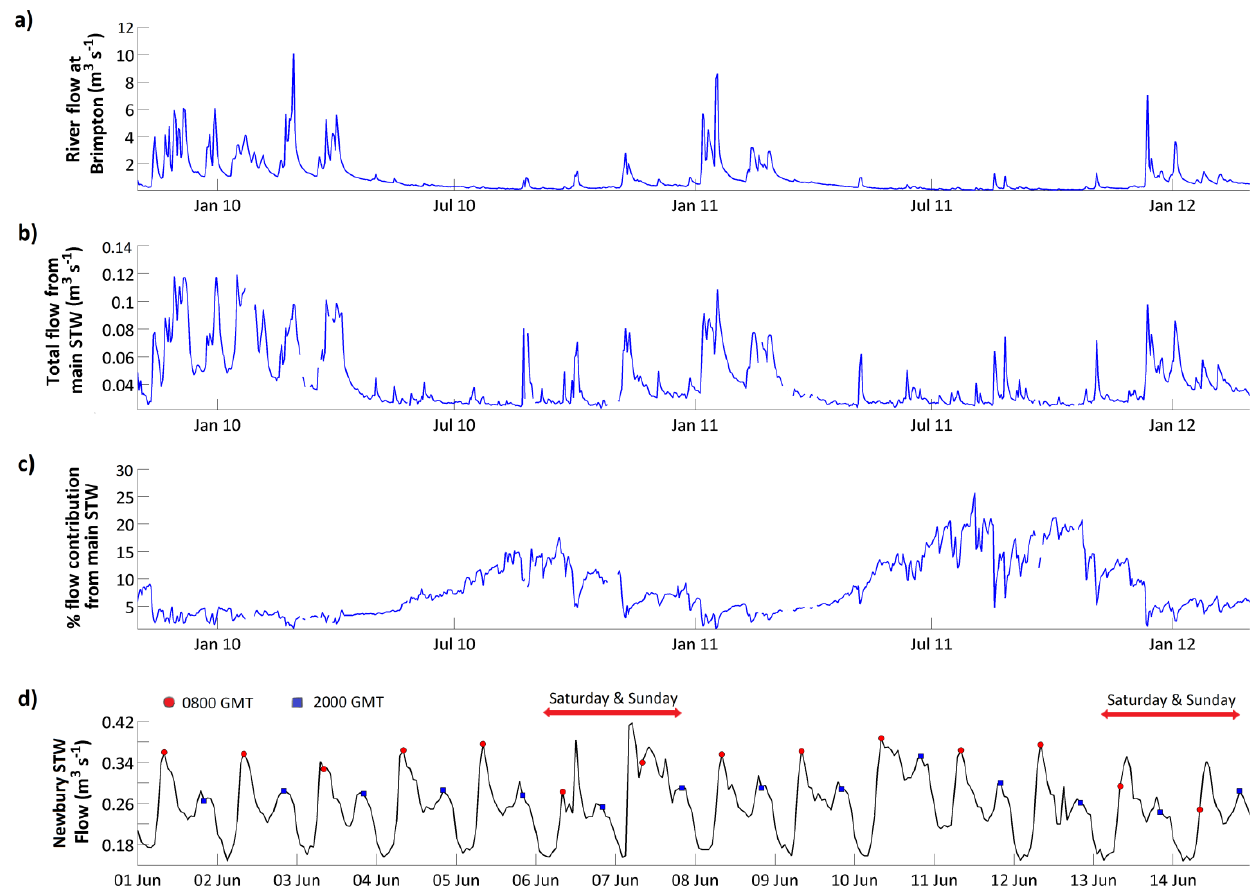
Figure 7. ( a ) Measured flow at Brimpton; ( b ) measured discharges from the three major sewage treatment works (Table 3); ( c ) Percentage contribution of STW discharges to observed river flow at Brimpton; ( d ) discharge from Newbury STW in June 2009, showing diurnal